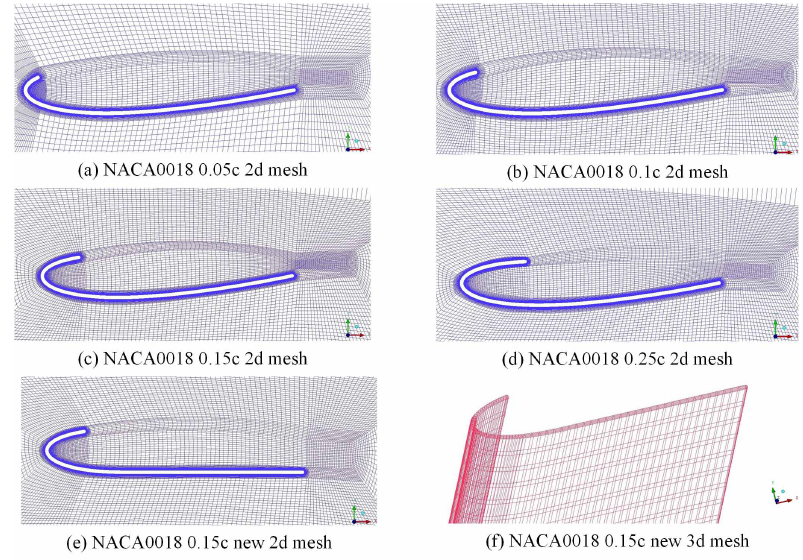
Figure 12. J-blade wind generator 2D and 3D